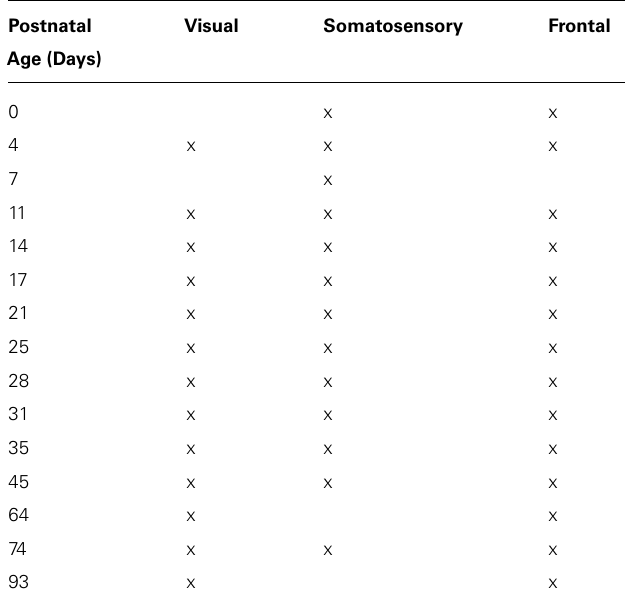
Table 1 | Cortical tissue